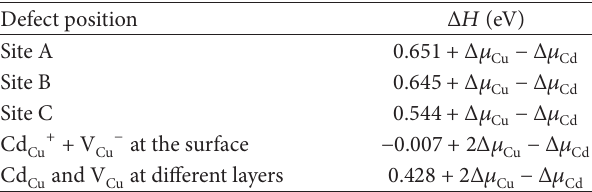
+ + V − at the surface layer. (b) The two defects Cd Figure 3: (a) The defect pair Cd Cu Cu yellow balls represent Cu, In, and Se atoms, respectively. The squares represent Cu vacancies. The green ball is the Cd atom. Table 3: Defect formation energy.